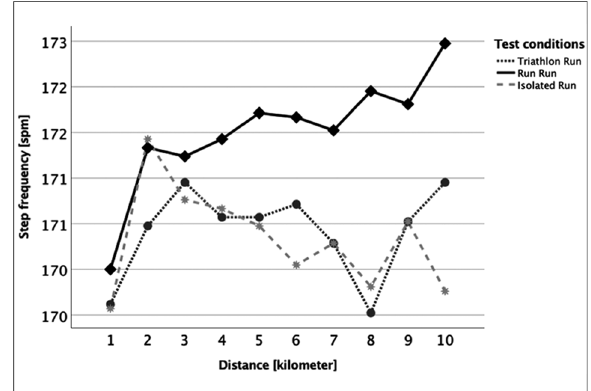
FIGURE 4 Kilometer-separated development of step frequency between the three running conditions (Triathlon Run=dark grey dotted line; Run Run=black solid line; Isolated Run=grey dashed